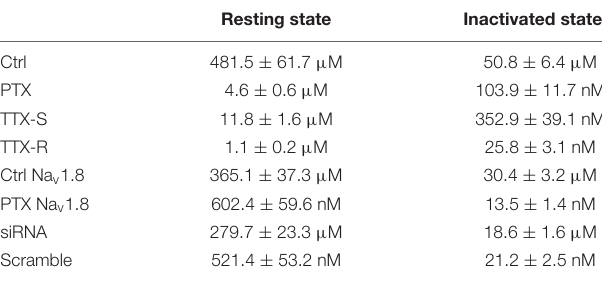
TABLE 2 | The IC 50 values in different models of DRG neurons.